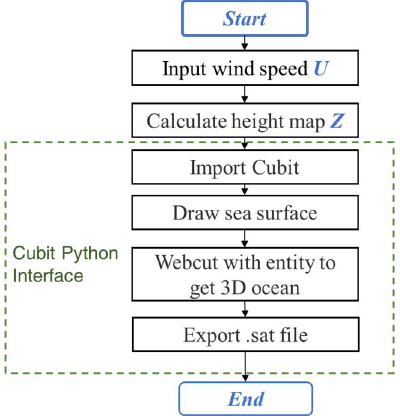
Figure 8. Python API provided by CUBIT offers batch generation ability. In this research, the input parameter is only the wind speed vector.